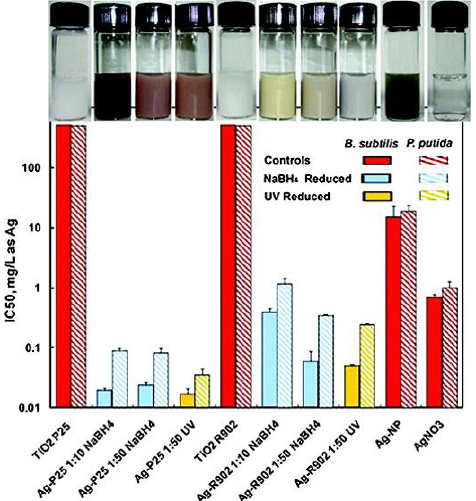
Figure 1. IC50 values of di ff erent hybrid Ag-TiO 2 nanoparticles with and without UV light irradiations. TiO 2 P25 (Degussa P25) and TiO 2 R-902 (DuPont Ti-Pure R-902) were two commercial TiO 2 nanoparticles. Two di ff erent molar ratios of AgNO 3 and TiO 2 including 1:10 and 1:50 were respectively employed to prepare Ag nanoparticles deposited onto the TiO 2 nanoparticles by NaBH 4 reduction and UV photoreduction to form the samples of Ag-P25 1:10 NaBH 4 , Ag-P25 1:50 NaBH 4 , Ag-P25 1:50 UV, Ag-R902 1:10 NaBH 4 , Ag-R902 1:50 NaBH 4 and Ag-R902 1:50 UV. Ag nanoparticles and AgNO 3 were purchased from QuantumSphere, Inc. Reproduced with permission from ref. [68]. Copyright © 2011, American Chemical